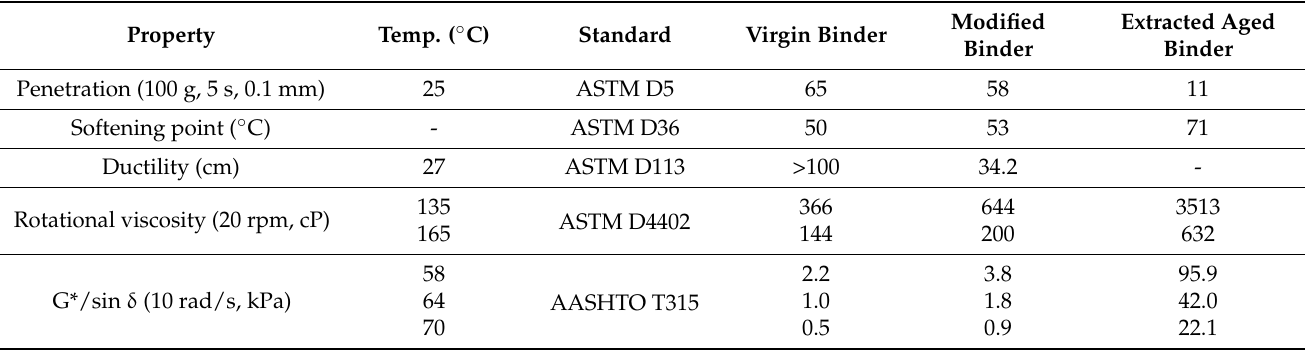
Table 2. Properties of the asphalt